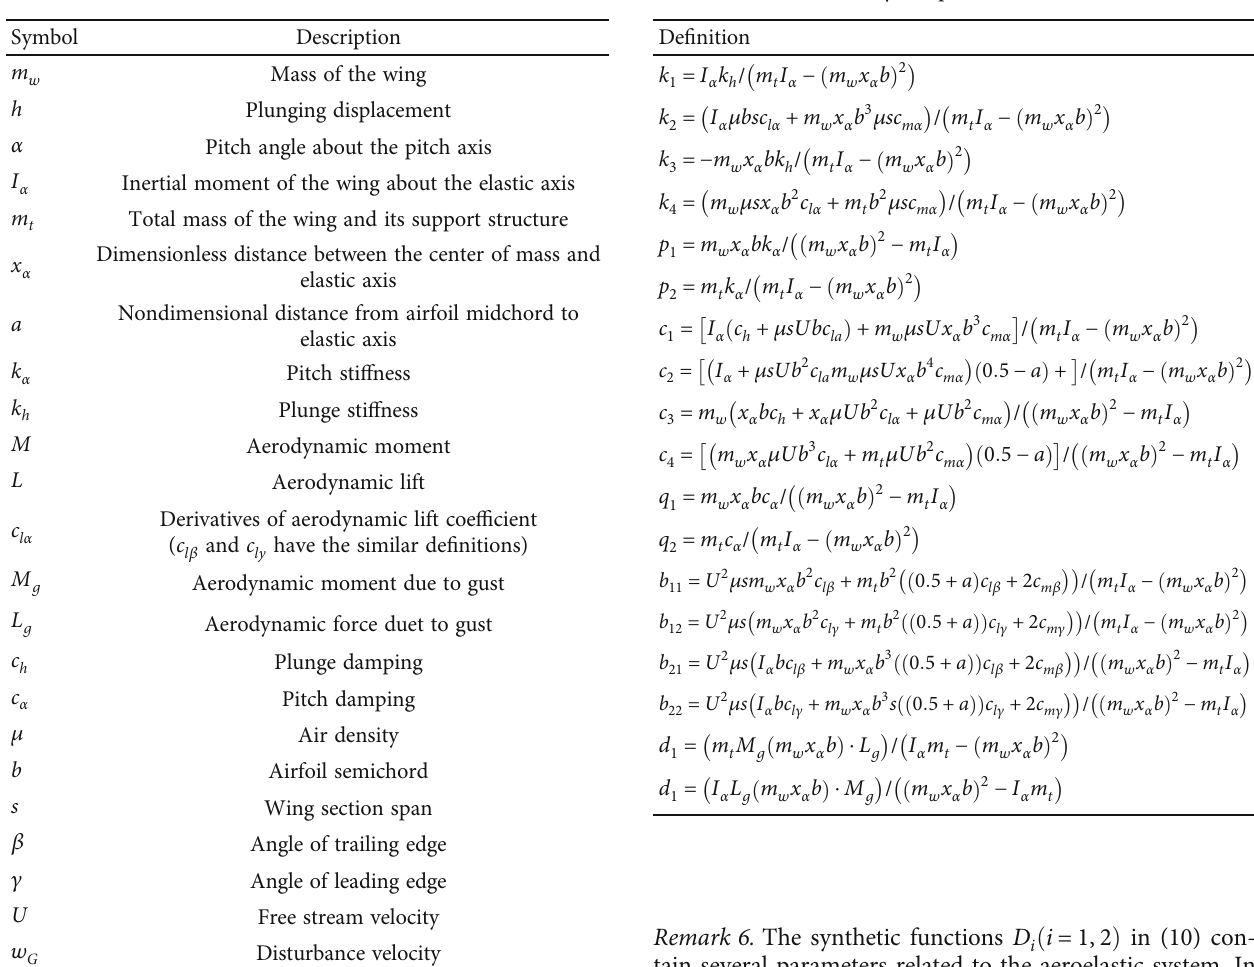
Table 2: Hybrid parameter de fi nition. Table 1: